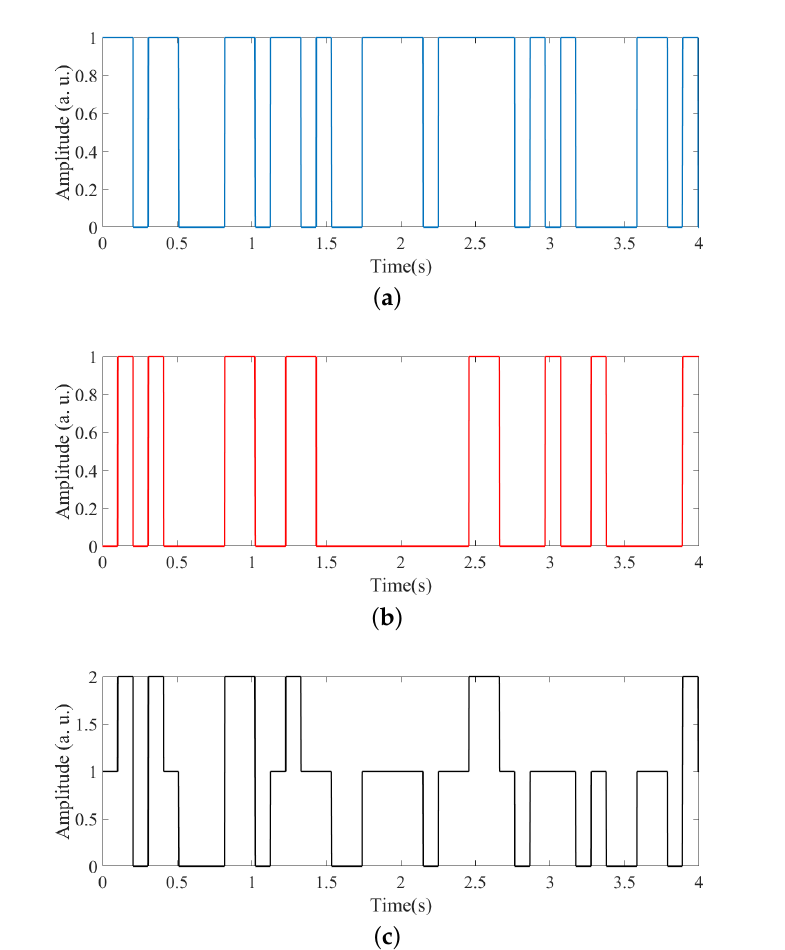
Figure 4. Structure of the digital signal I d used as bias and fed to the laser pump. ( a ) Temporal behavior of I 1 , while I 2 is shown in ( b ), being I d = I 1 + I 2 shown in ( c